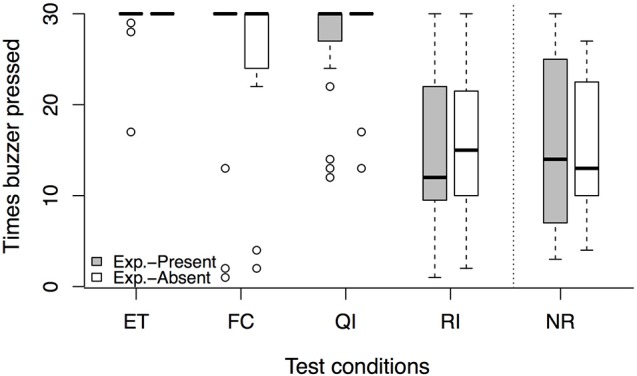
Number of times the buzzer was pressed per test condition in the experimenter-present (gray) and experimenter-absent (white) version of the buzzer task. Circles show outliers, black bars indicate median values, whiskers display upper and lower hinge, and boxes show the interquartile range. ET, equity; FC, food control; QI, quality inequity; RI, reward inequity; NR, no-reward control.